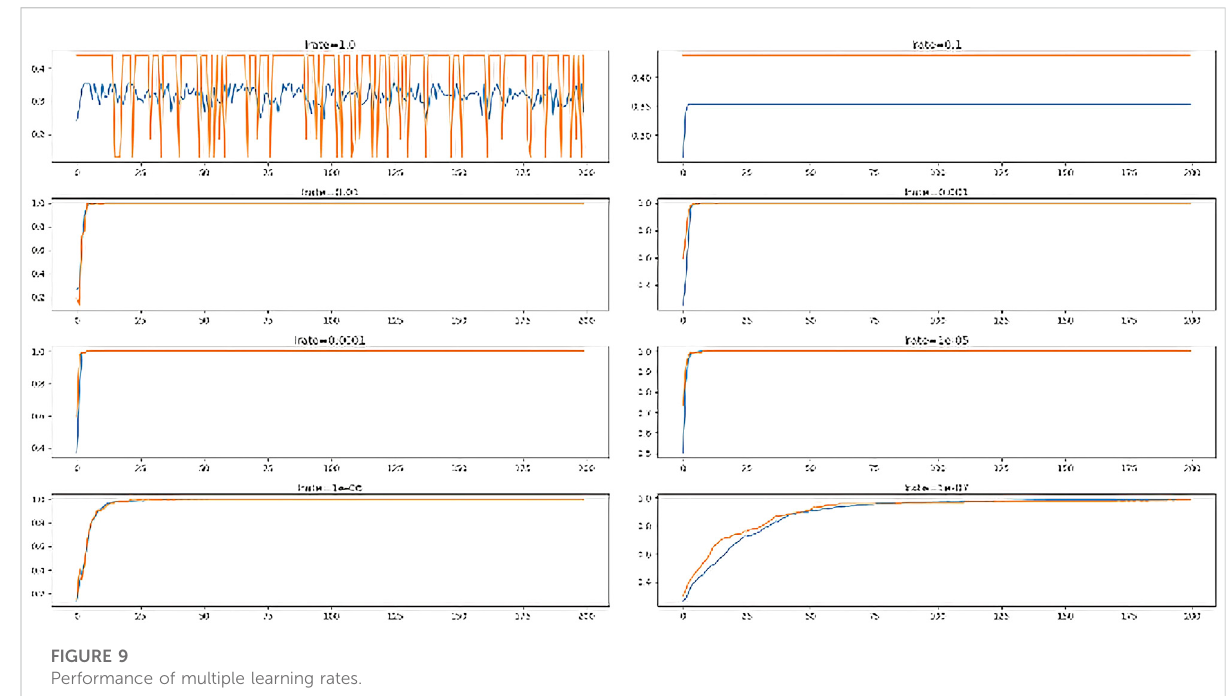
FIGURE 9 Performance of multiple learning